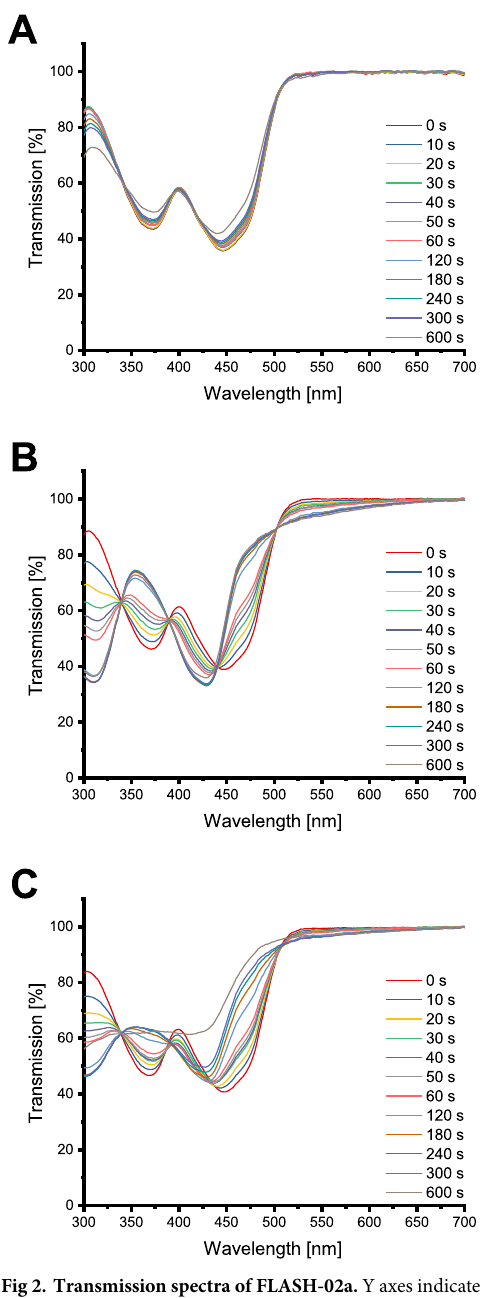
Fig 2. Transmission spectra of FLASH-02a. Y axes indicate the transmission in per cent, x axes the wavelength in nm. Various colors of the spectra indicate different irradiation times. (A) shows the results for H 2 O, (B) for 75 mmol l -1 sodium phosphate and (C) for 75 mmol l -1 sodium